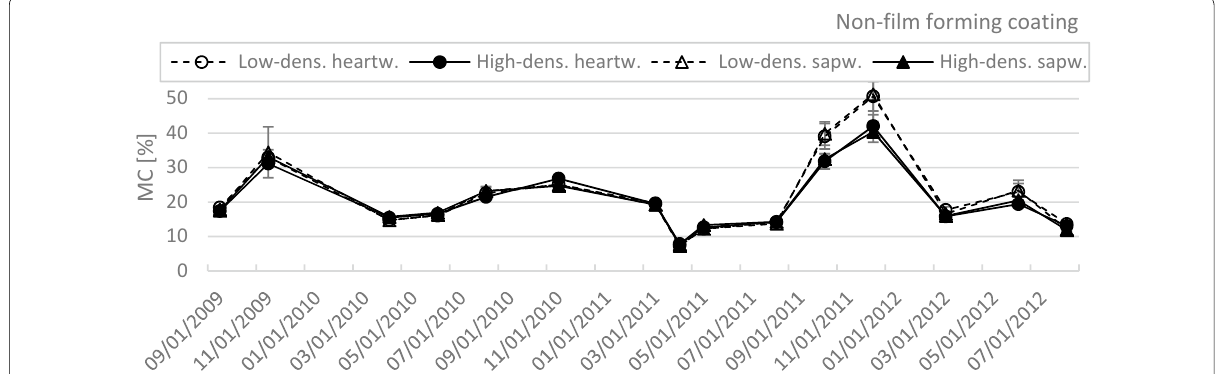
Fig. 4 MC fluctuation over 3 years for the non-film-forming coating D, categorised by high- or low-density heartwood or sapwood. The error bars represent the standard deviation of the values. The climate data during the period are given in Fig. 1b